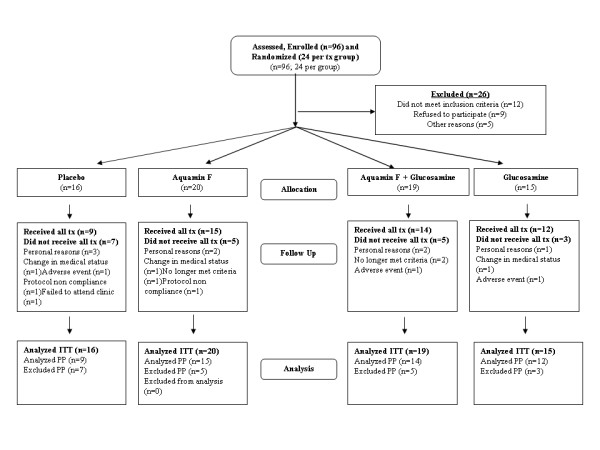
Trial flow chart.